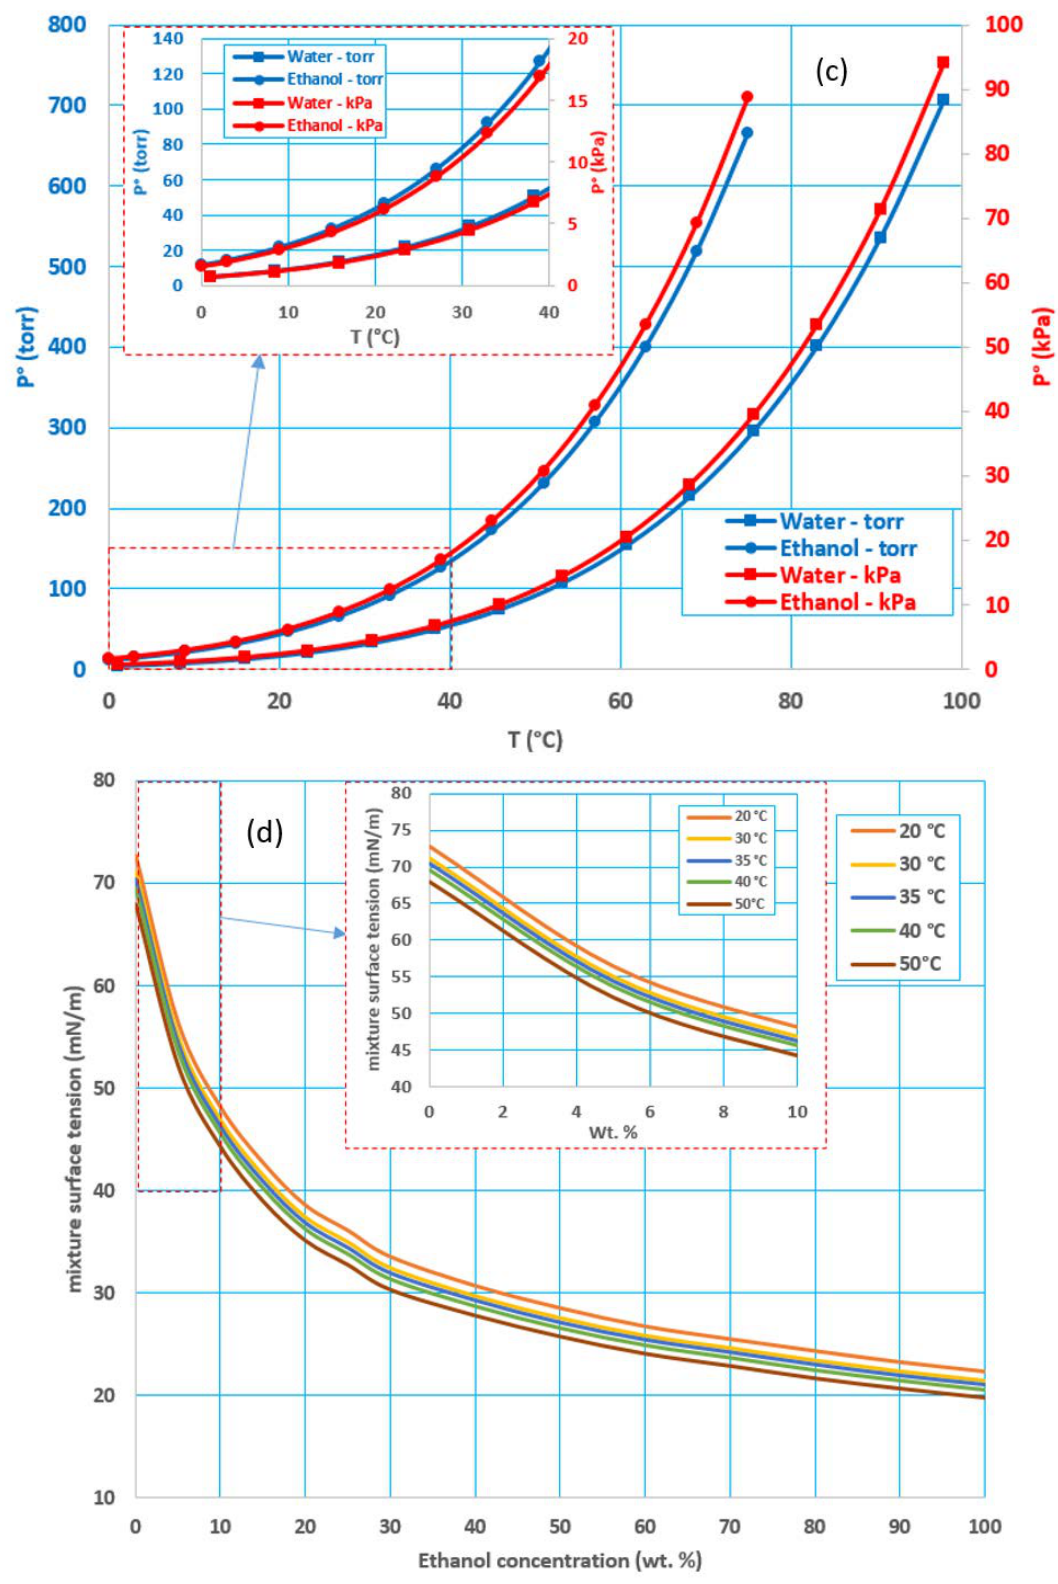
Figure 3. Effect of the feed temperature on ( a ) permeate flux, and ( b ) the separation factor at different concentrations, a 0.6 L/min feed flow rate, and 60 mmHg (abs) pressure. ( c ) Vapor pressure with temperature for water and ethanol. ( d ) The ethanol–water mixture surface tension with